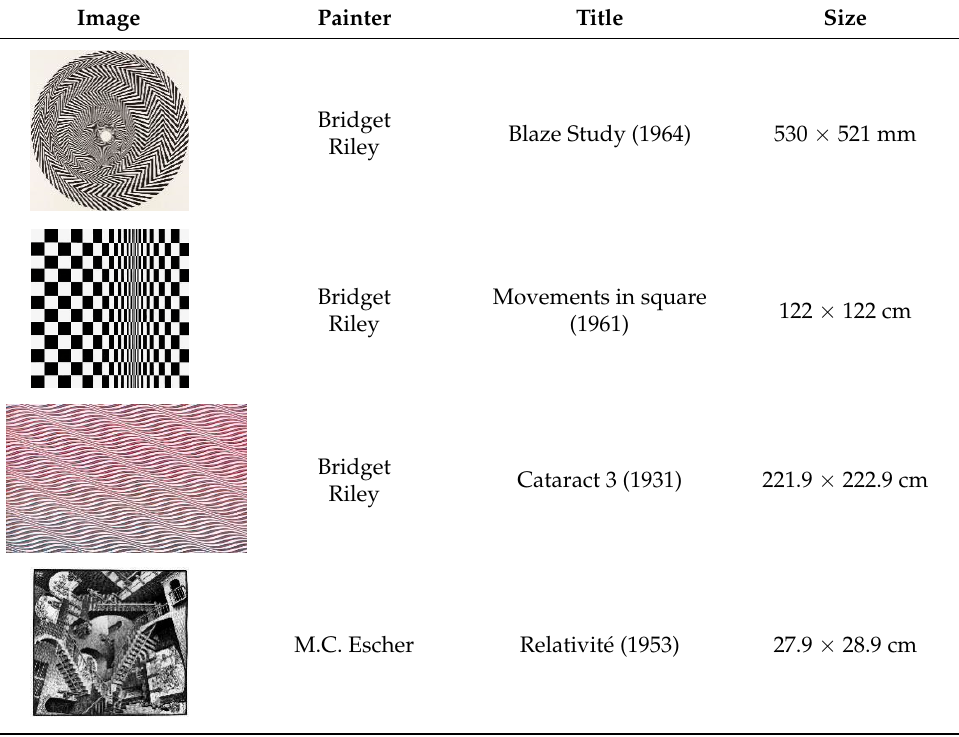
Table 1. Presentation of the seven paintings tables where the children were looking during the data